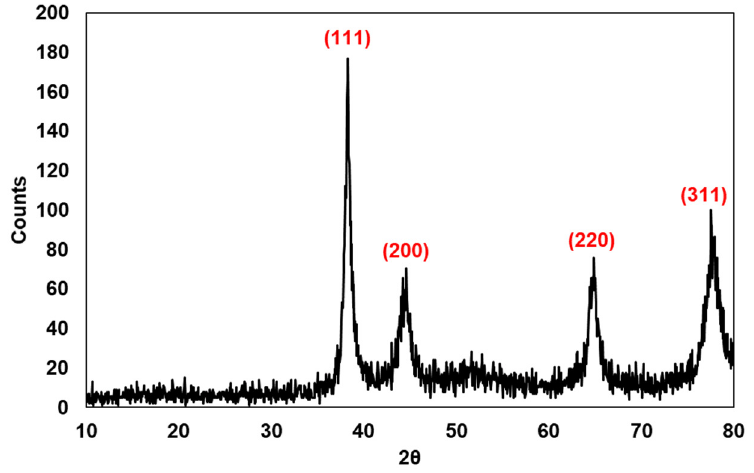
Figure 6. The XRD spectrum of biosynthesized CC-AuNPs.